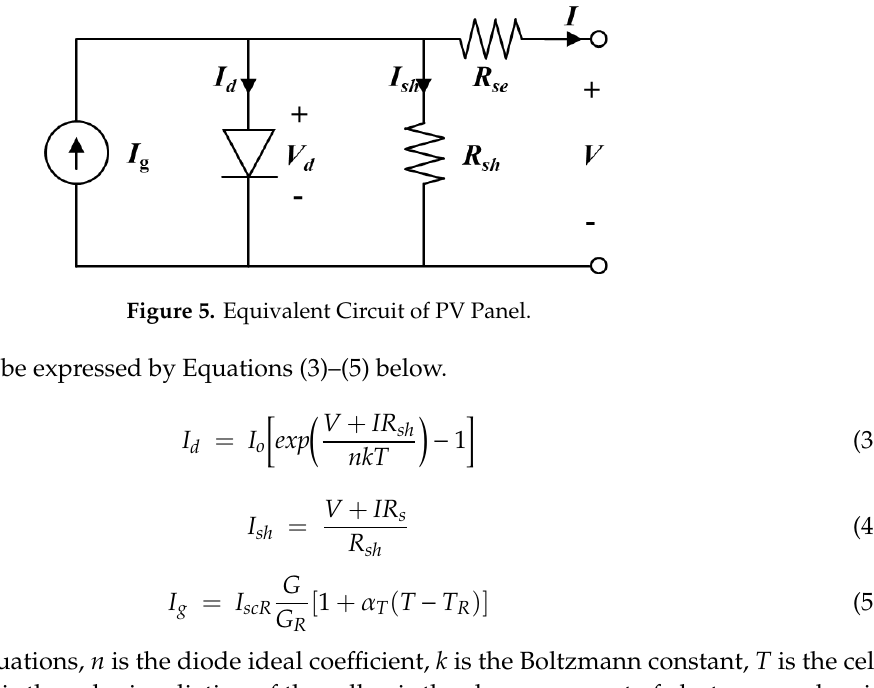
Figure 4. Control Block Diagram of VSC (Voltage-Sourced Converter) for Active and Reactive Power Control.